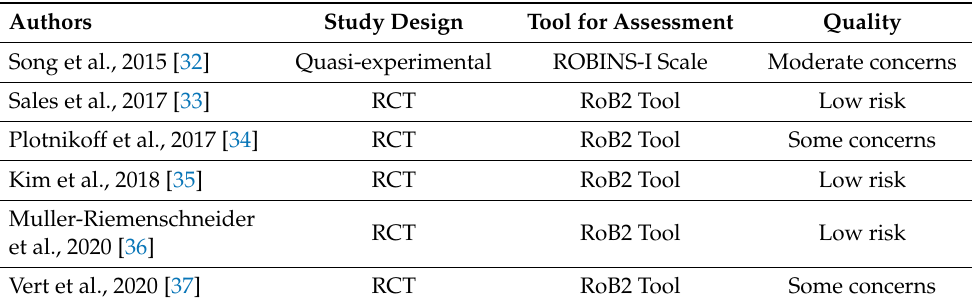
Table 2. Quality assessment of RCTs and quasi-experimental